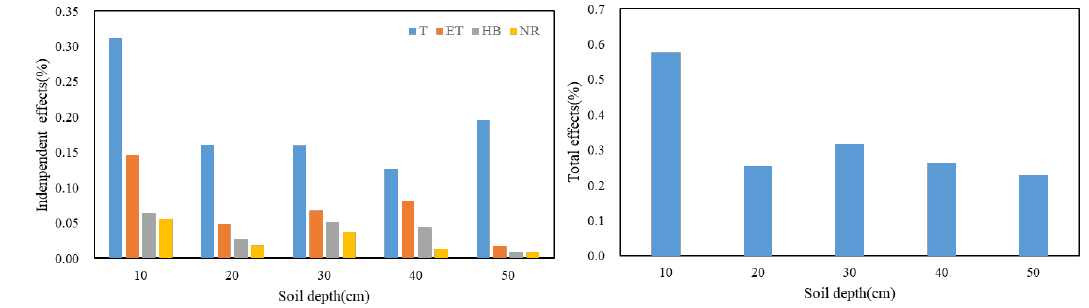
Figure 10. Independent and total effects of environmental factors on soil water content.